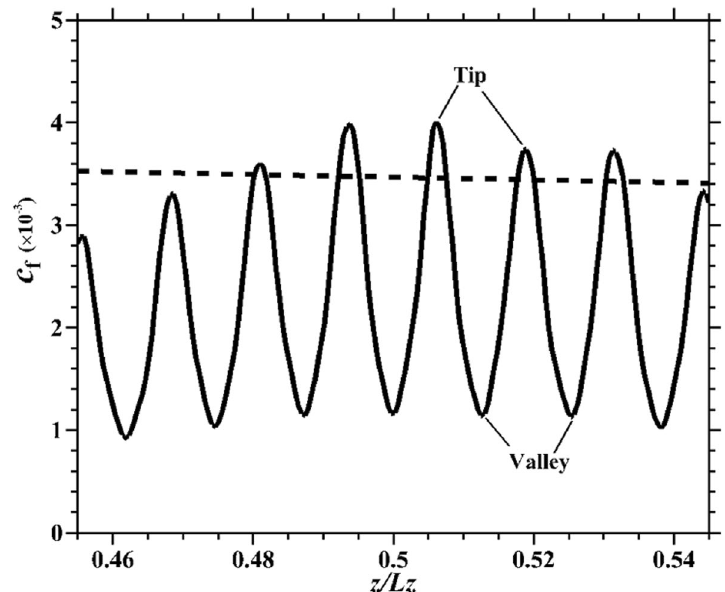
Fig. 11 Spanwise distribution of local friction drag coefficient on riblets (solid lines) and smooth (dashed line) flat-plate